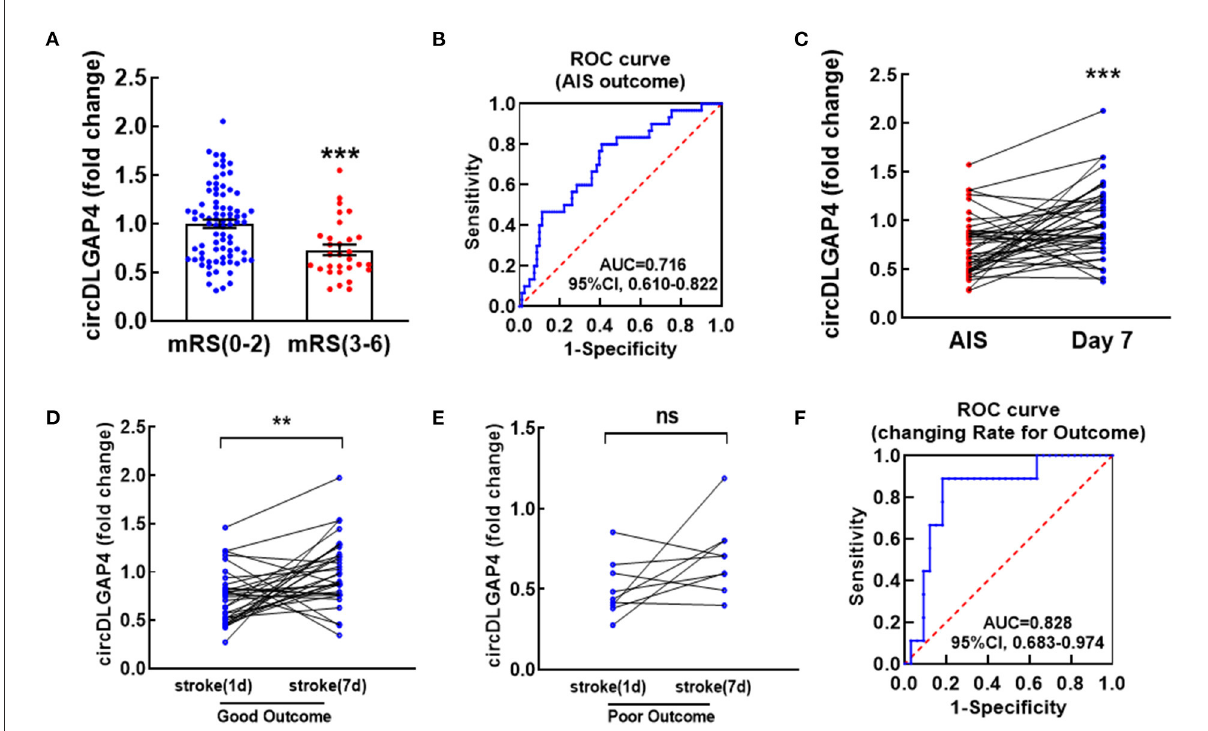
FIGURE3 Temporal expression profiles of circDLGAP4 according to modified Rankin Scale (mRS) at 3 months after stroke and their values in predicting outcomes. (A) Relative plasma circDLGAP4 levels on the 1st day in patients with good (mRS 0-2) outcomes vs. poor (mRS 3-6) outcomes 3 months later; n = 81 in the good outcome group and n = 30 in the poor outcomes group. *** p <0.0001 using the Mann–Whitney. (B) The ROC curve for individual circDLGAP4 on the 1 st day to separate good (mRS, 0–2) outcomes from poor (mRS, 3–6) outcomes 3 months later. (C–E) Relative plasma circDLGAP4 levels of total (C) , good outcome (D) and poor outcome (E) patients with AIS at Day 1 vs. Day 7 after treatment. *** p < 0.001 using the Wilcoxon matched-pairs signed rank test. AIS indicates acute ischemic stroke. (F) The ROC curve was evaluated by the changing rate ( 1 value/fold change on the 1st day) of patients with AIS. mRS: modified Rankin